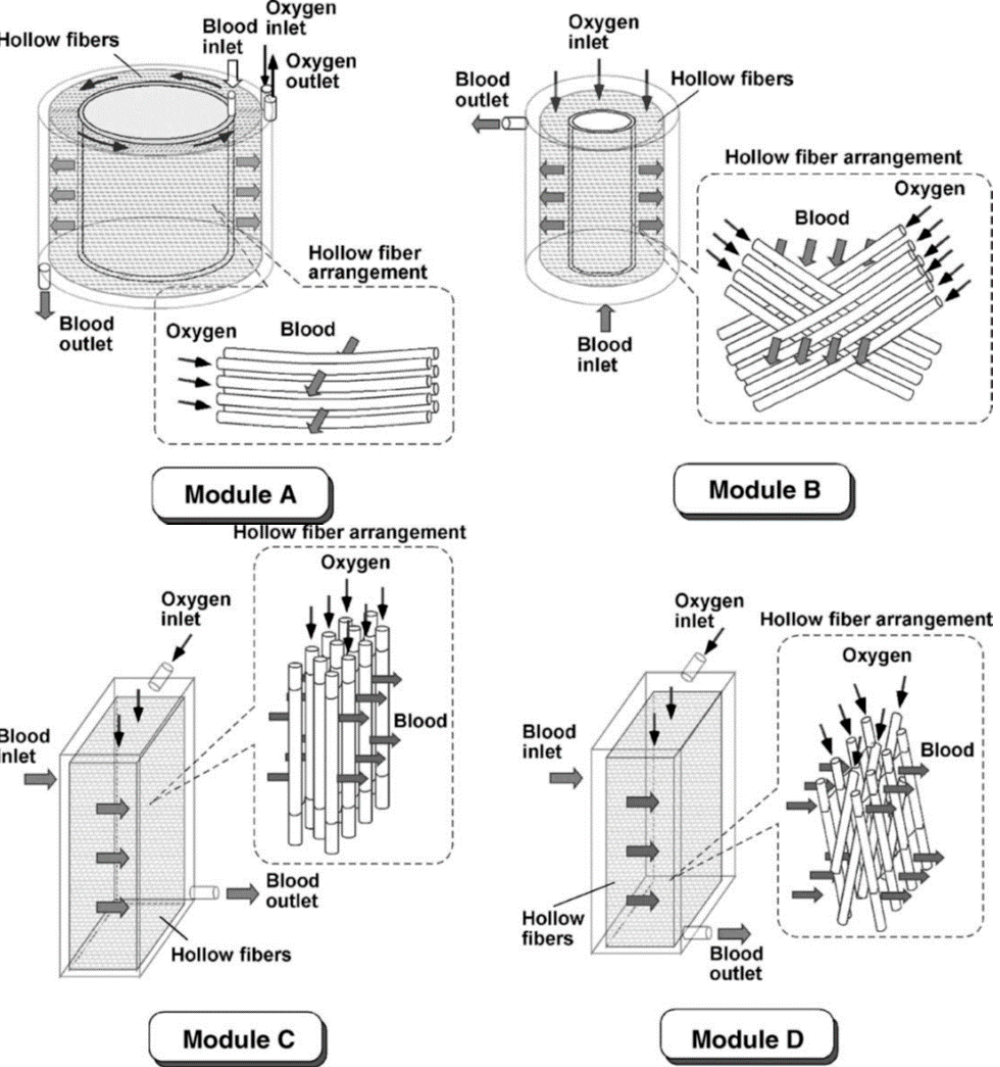
Figure 6. Hollow fiber arrangement in parallel (module) ( A , C ) and in perpendicular (module) ( B , D ); blood flow direction in coiled construction design (module) ( A , B ) and in rectangular solid design (module) ( C , D ). (Reprinted with permission from [36].).